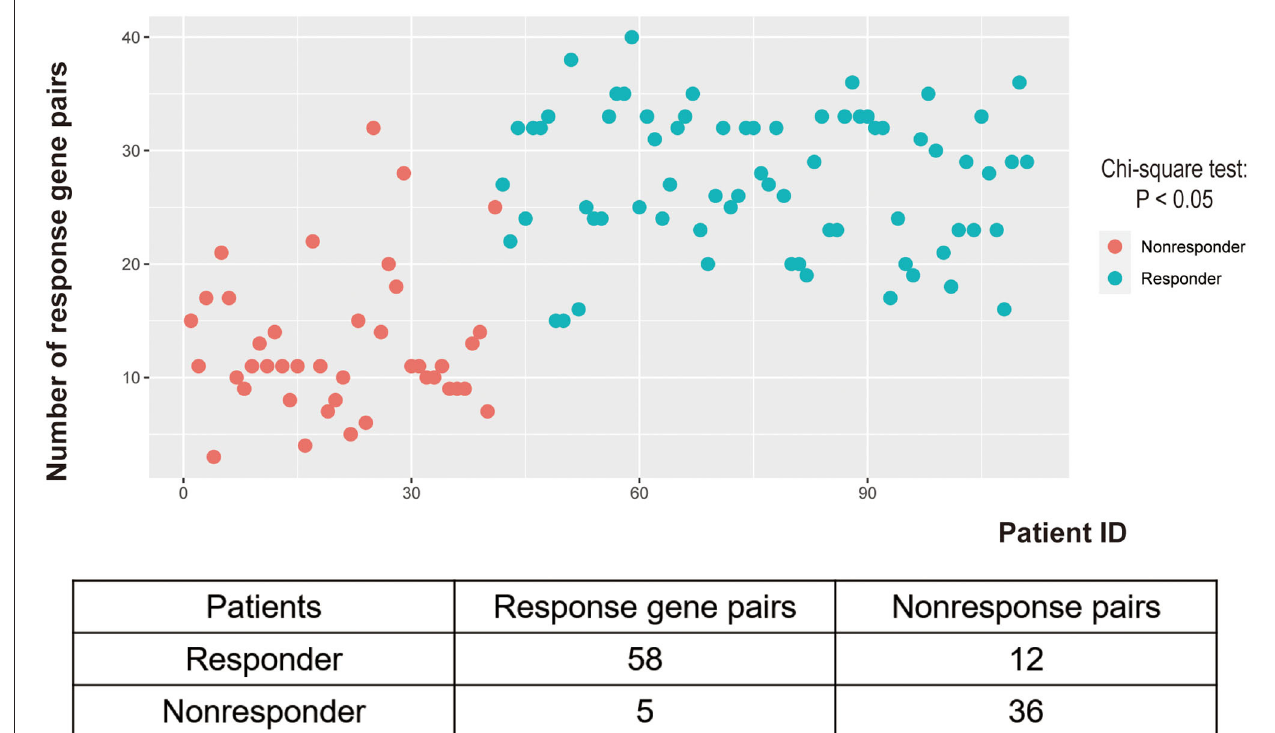
FIGURE 2 | Distribution of response gene pairs in patients of GSE87211 under 41-GPS prediction.